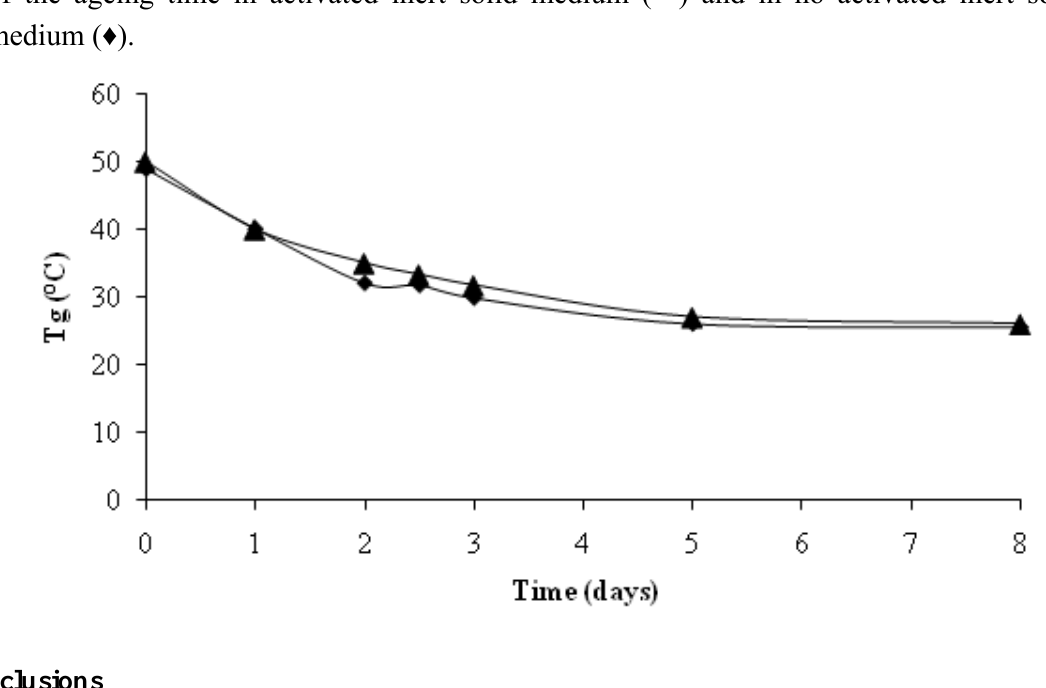
Figure 8. Evolution of the glass transition temperature of non-degraded PLA as a function of the ageing time in activated inert solid medium ( (cid:99) ) and in no activated inert solid medium ( ♦